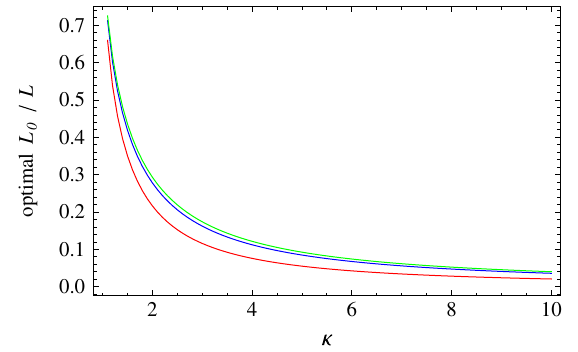
FIG. 17. Parameters of optimal linear-ramped bending pro- files. The constant peak field segment is (cid:12) times the reference uniform dipole of the same length and bending angle, has a =L given by the curves (red, blue, and green fractional length L 0 for TME, AME, and EME, respectively), and contributes ð L =L Þ (cid:12) percentage to the bending angle. The end field is 0 weaker by a factor of r , which is plotted in Figs. 3, 8, and